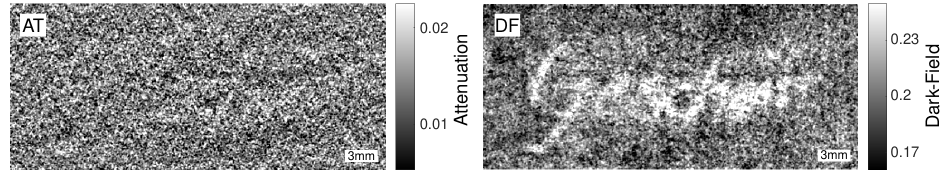
Figure 2. Attenuation ( left ) and dark-field image ( right ) of the word Gescheit written with thorn ink on 90g/m 2 cotton paper. The scale bar is 3mm wide in the object